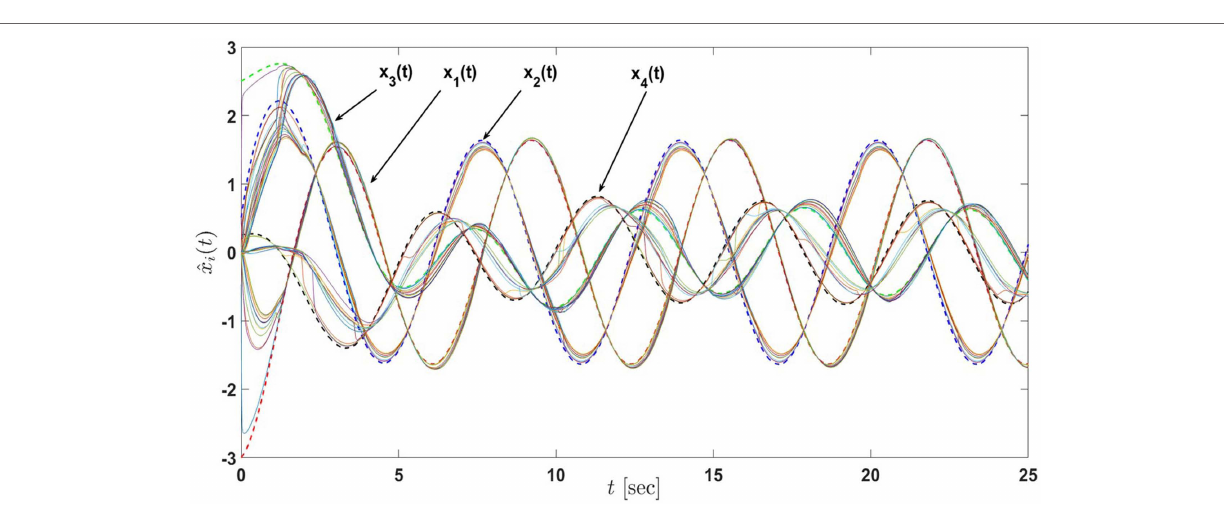
Fr ontiers in Robotics and AI |